Question: Express in one sentence what the figure is showing.
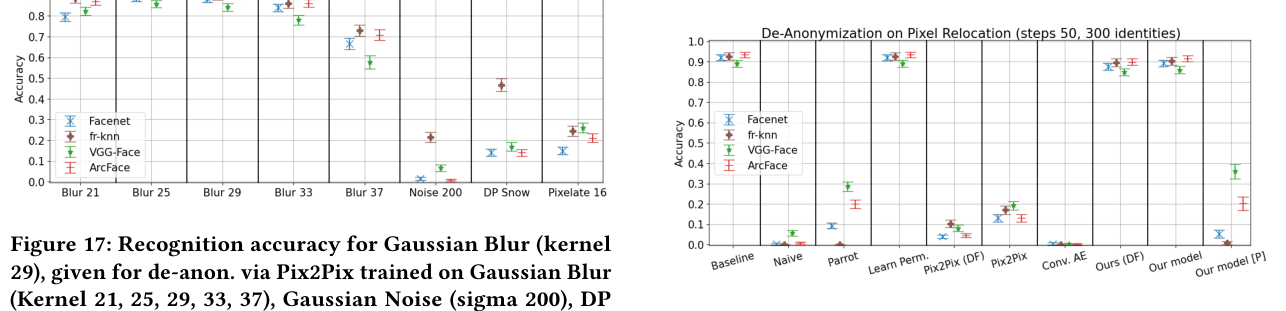
Answer: Recognition accuracy for Pixel Relocation, given for baseline, naive, parrot, de-anon. via Learn Permuta- tion, via Pix2Pix trained on DigiFace-1M, via Pix2Pix, via our model without linear layer, via our model trained on DigiFace-1M, via our model; on 300 identities of CelebA.